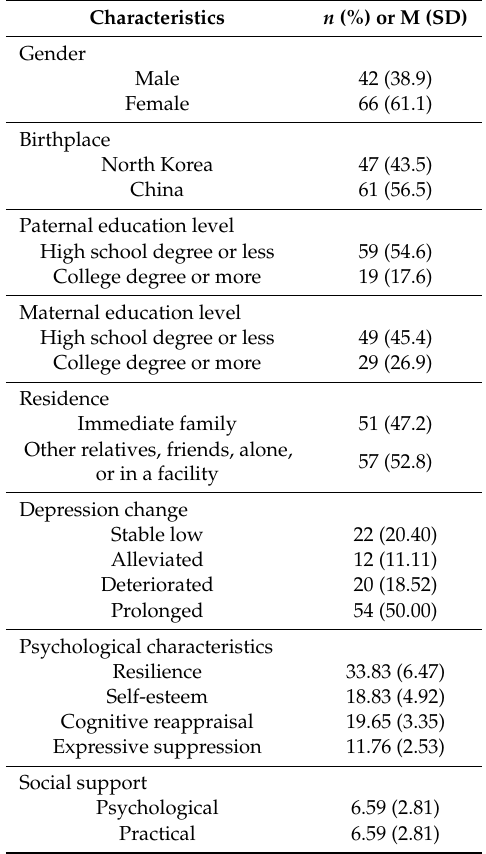
Table 1. Characteristics of participants ( n =